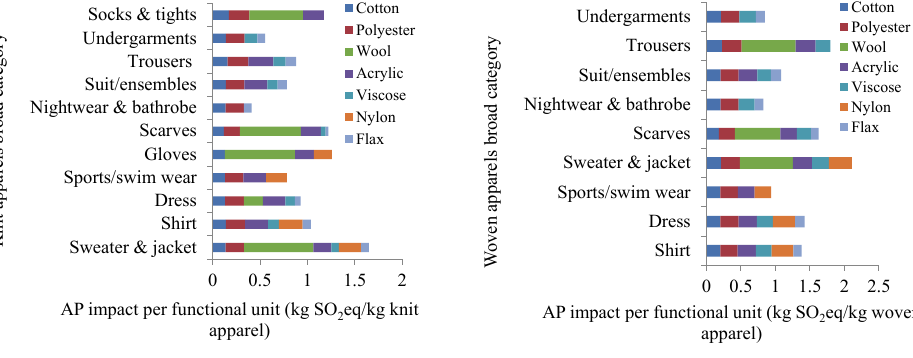
Fig. 8. AP impact (per kilo-gram apparel) of knit and woven apparel broad